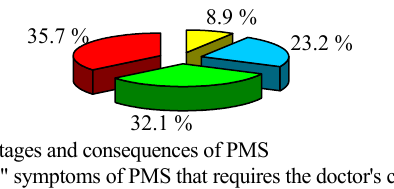
Fig. 4. Women’s answers to questions “What type of